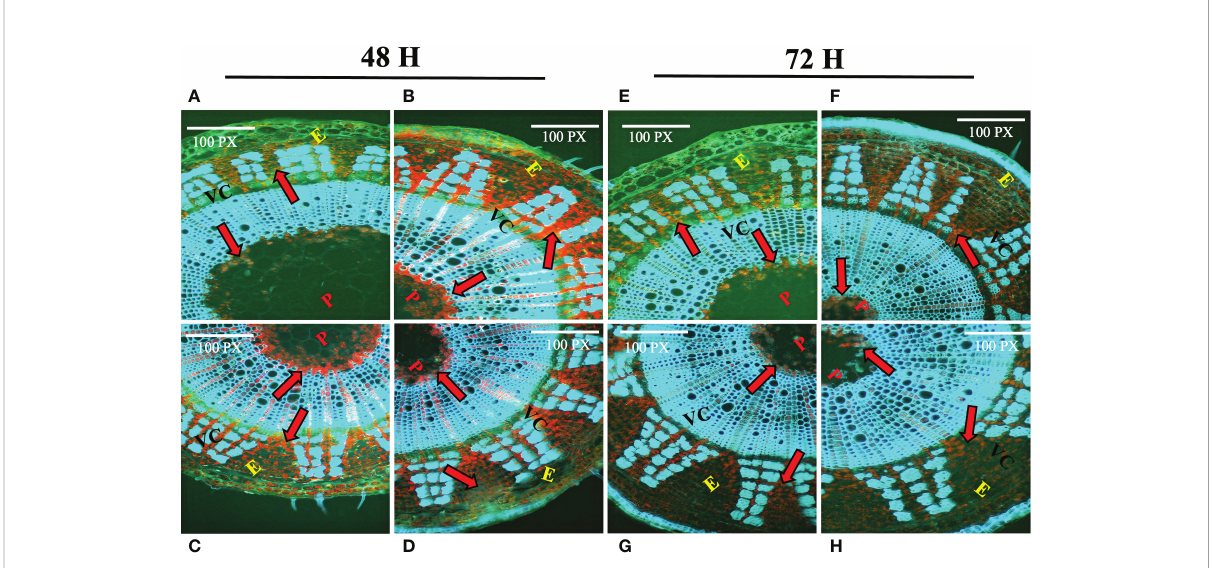
FIGURE 1 Histochemical assay of lignin deposition in two months old C olitorius stem under control and stressed conditions at different time intervals (48 hours and 72 hours). (A – D) Stem section of control and three stress treated plants (A) control (B) hormone (C) drought (D) salinity stress; after 48 hours; and (E – H) Stem section of control plant and three stress treated plants (E) control (F) hormone (G) drought (H) salinity stress; after 72 hours. Different letters indicate different regions of the stem (E, epidermis; VC, vascular cambium; P, pith). Red arrows indicate the deposition of